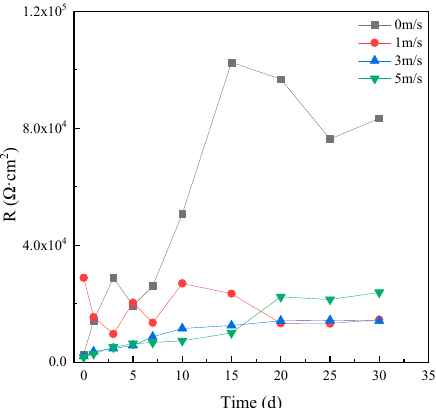
Figure 8. Corrosion resistance of HAZ in different flowing seawater varying with time .